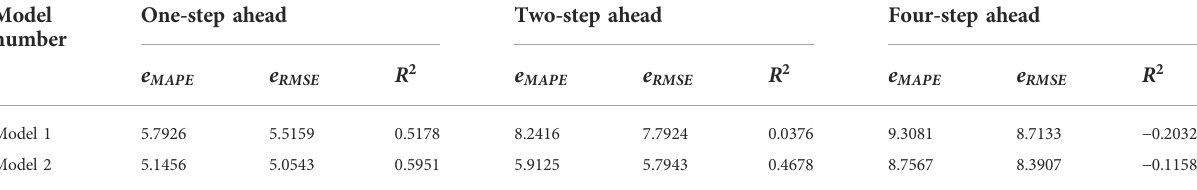
TABLE 8 Prediction results of models without decomposition technique (Case II).